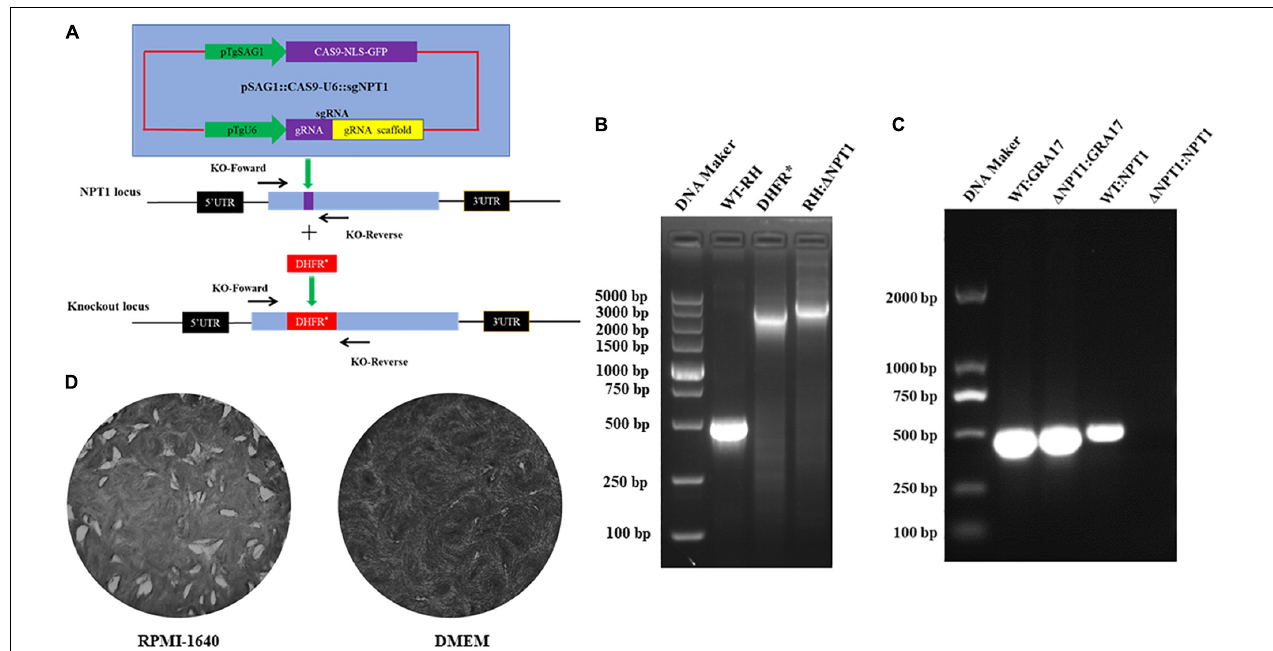
FIGURE 1 | Employment of CRISPR/Cas9 technology to knockout the NPT1 gene in the T. gondii RH strain. (A) Schematic illustration of the CRISPR-Cas9 method to disrupt the gene by insertion of the pyrimethamine-resistant DHFR ∗ . (B) KO- NPT1 -F and KO- NPT1 -R were used to amplify the target fragment, which can amplify the coding region in wild-type parasites and a larger fragment in the pyrimethamine-resistant clones. Diagnostic PCR confirming the selection maker DHFR ∗ cassette’s successful integration into the NPT1 gene (RH: (cid:49) NPT1 ). (C) RT-PCR were used to amplify the target fragment, which can amplify the coding region in the wild-type parasites, but did not amplify the targeting aim gene in the NPT1 -deficiency clones. The GRA17 gene fragment as the positive control of RT-PCR detected were amplified in wild-type and RH: (cid:49) NPT1 strain. Diagnostic PCR confirming the selection maker DHFR ∗ cassette successful integration into the NPT1 gene (RH: (cid:49) NPT1 ). (D) Growth analysis of RH: (cid:49) NPT1- infected human foreskin fibroblast cells. RH: (cid:49) NPT1 was normal growth and developed plaque in the RPMI-1640 medium, but its growth capability was remarkably attenuated in the DMEM medium, indicating the successful deletion of the NPT1